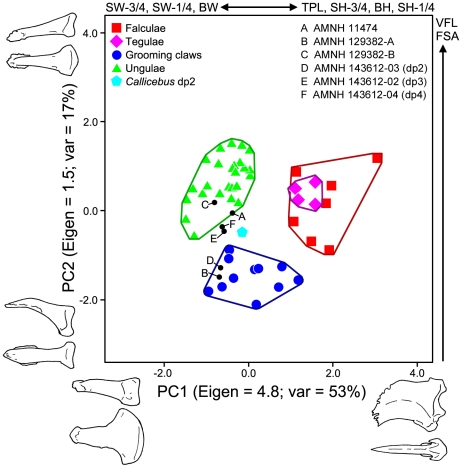
Principle components analysis of distal phalanx morphology.The first two components of a principal components analysis of ungual morphology are plotted. Notharctus tenebrosus specimens are represented by black dots. Specimens illustrated along the axes represent the extreme points along each axis: x axis, Nycticebus coucang (dp2) and Galeopterus variegatus; y axis, Nycticebus coucang (dp3) and Hylobates sp. Variables which are most strongly correlated with each component are also listed along the axes. See Table 3 and Materials and Methods for abbreviations and measurement descriptions.